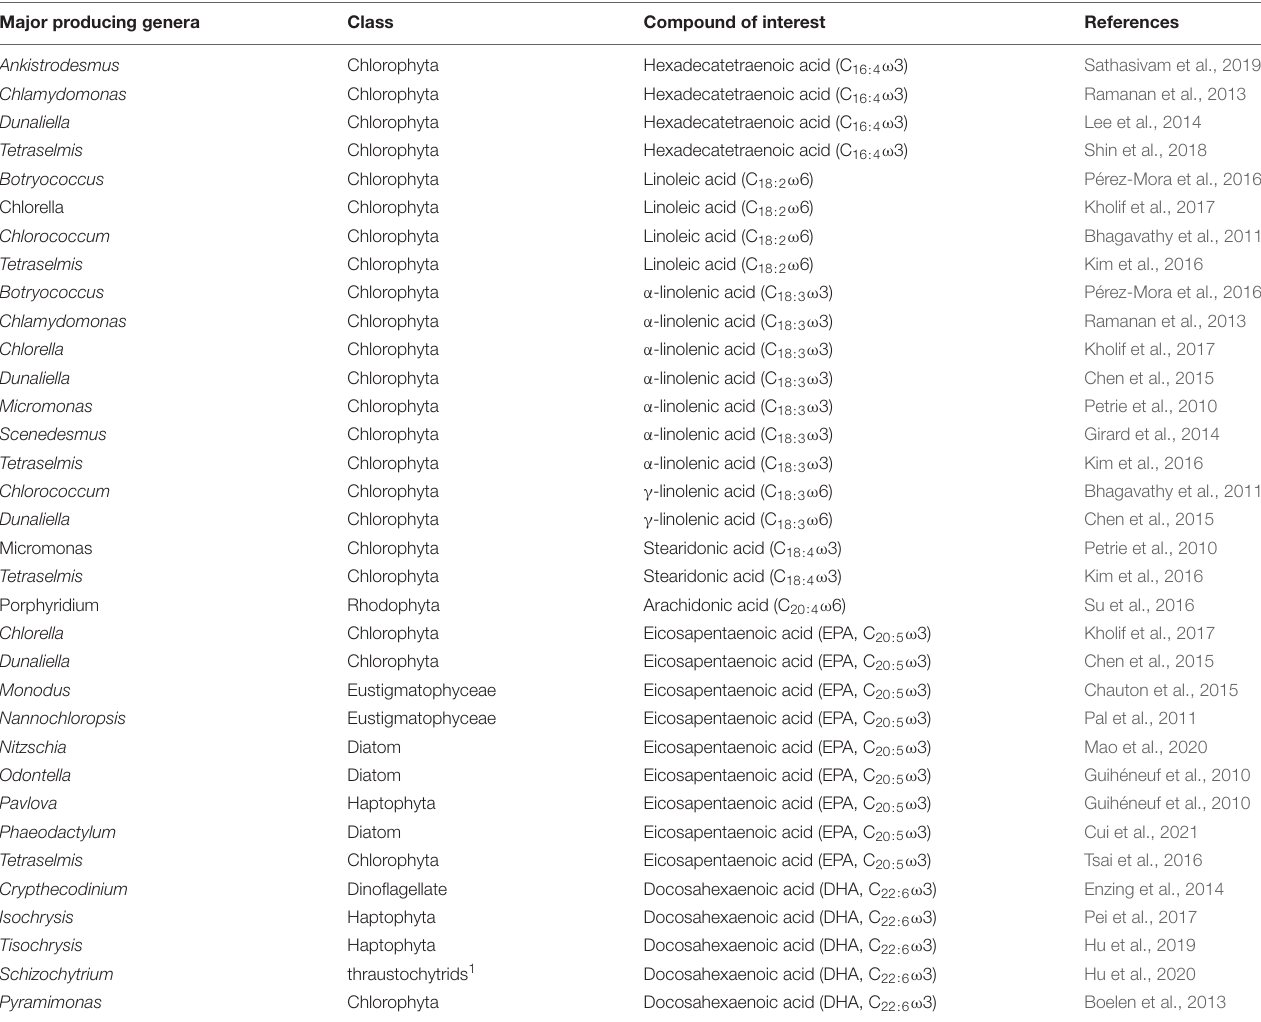
TABLE 1 | Major producers of polyunsaturated fatty acids